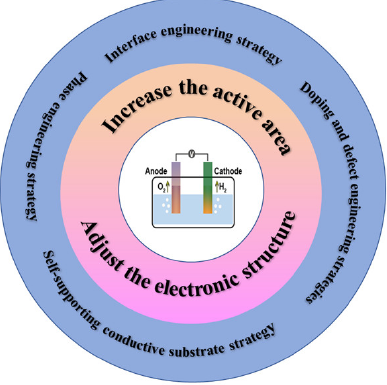
Figure 1. Schematic diagram of the engineering strategy for manganese-based materials.